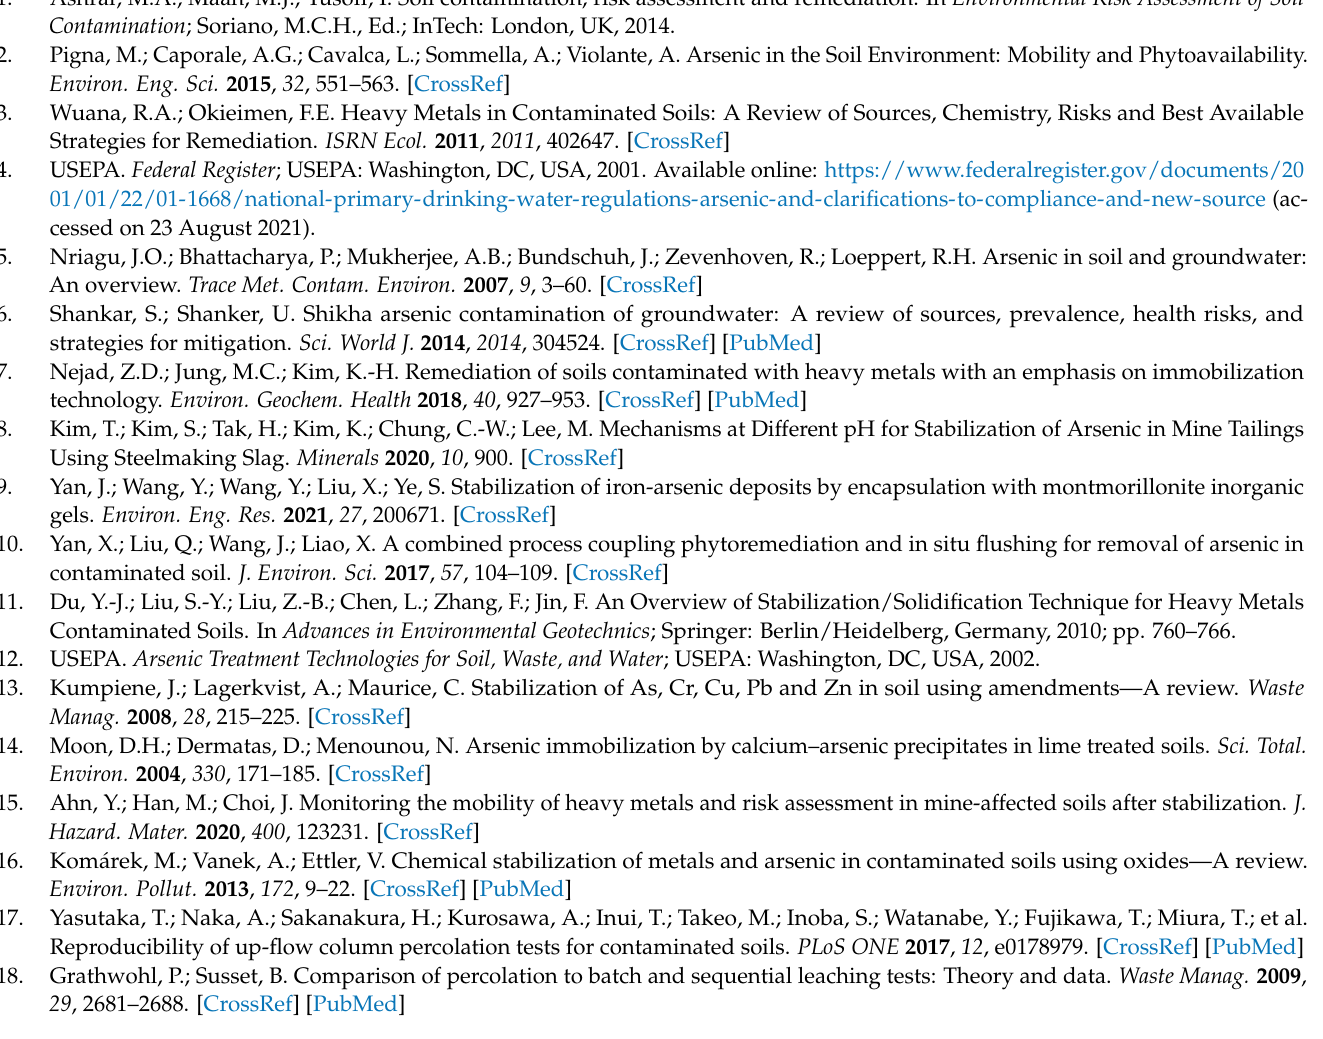
Figure S3: Eluate concentration curves for the release of various metals (Na, Mg, K, Ca, and Fe) from different soil columns as a function of L/S ratio in the percolation test (mean concentrations were obtained from three replicates). Figure S4: Percentage composition (%) of different stabilizing agents used in this study. The component portions were analyzed using X-ray fluorescence spectrometry (XRF-1800, SHIMADZU, Kyoto,